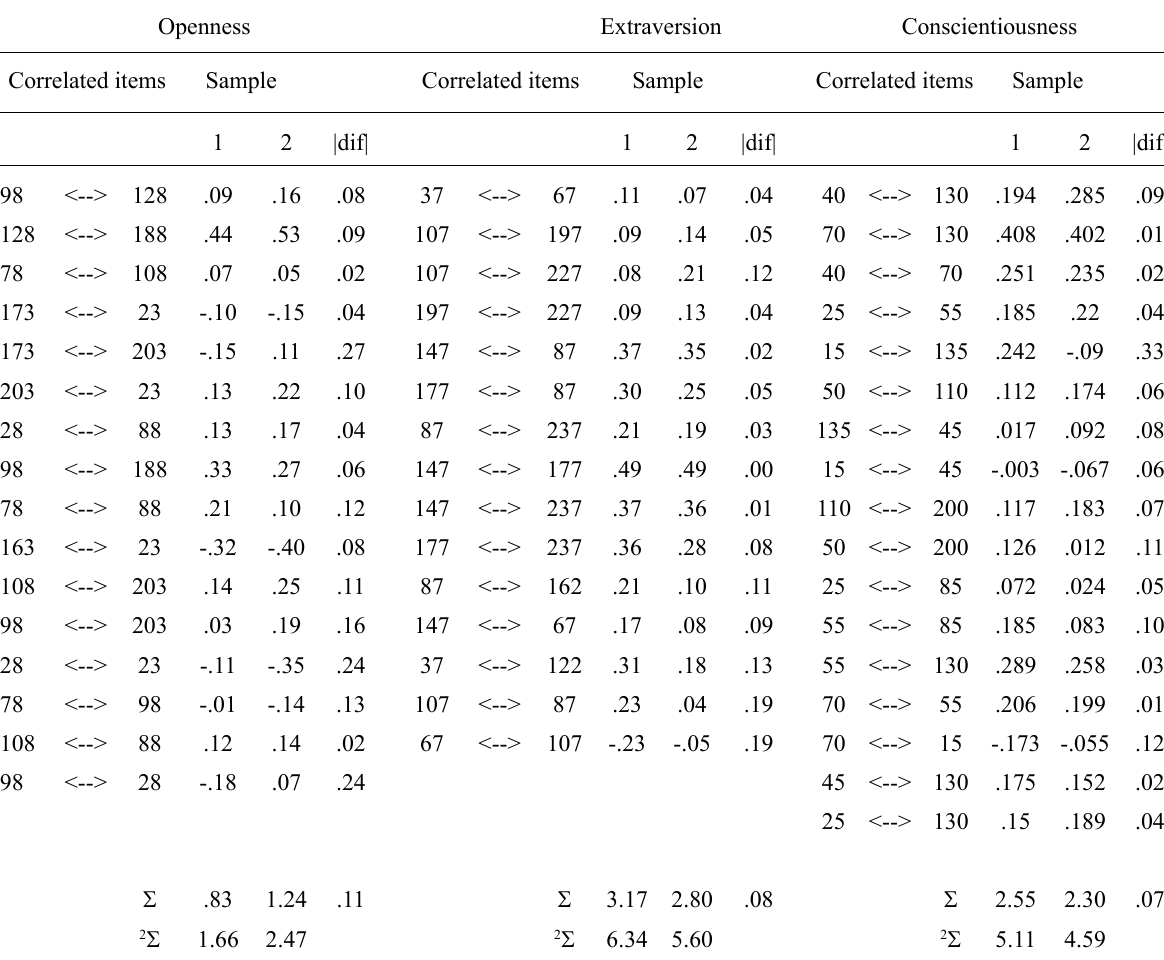
Completely Standardized MLE Residual Correlations for Satisfactory Fitting Single-Factor Models: Openness, Extraversion and